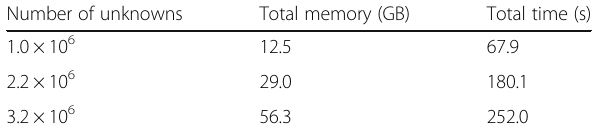
Table 3 The computational costs of the FETI-DP for calculating the optical force in the system of gold truncated cone